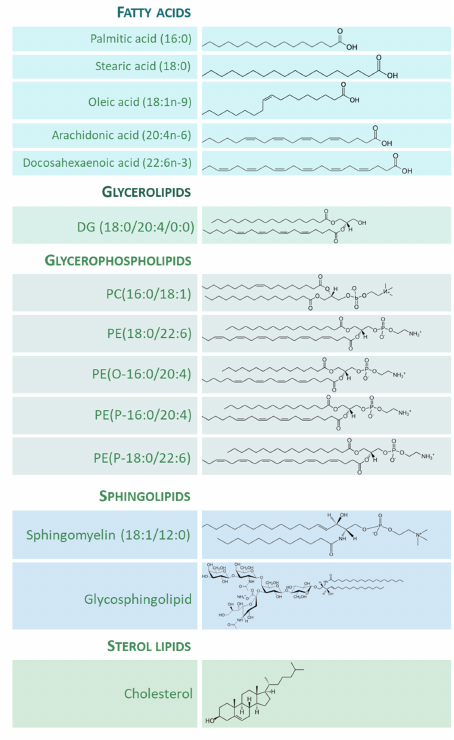
Figure 1. Representative lipid categories and specific molecular species present in the adult human brain. Fatty acids (FAs) shown characterize around 80–90% of total FA profile of the human brain ([13,14]). Glycerolipids (GL) in human brain comprise mono-, di-, and tri-acylglycerols. Glycer- ophospholipids (GP) are the major components ubiquitously found in neural cells; glycerophospho- cholines, glycerophosphoethanolamines, glycerophosphoserines, and glycerophosphoinositols are the main GP present in the human brain [8]; molecular species represented are particularly